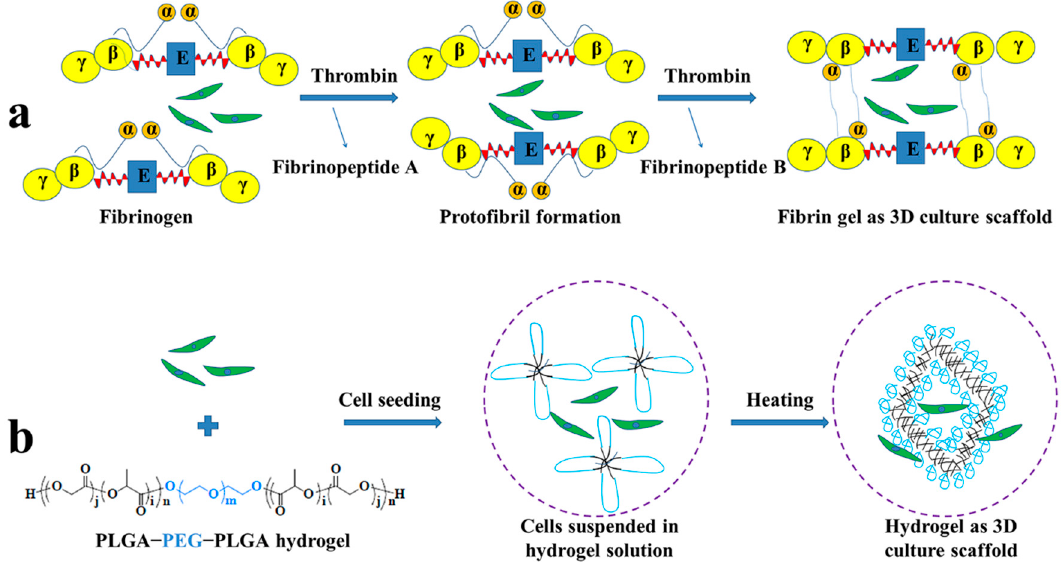
Figure 1. ( a ) Schematic representation of fibrin gel aggregation and BMMSCs incorporation; ( b ) BMMSCs-encapsulated PLGA − PEG − PLGA hydrogel acted as sca ff old for cartilage tissue engineering. Fibrinogen is composed of two sets of A α -, B β - and γ chains. Each α -chain is connected to the E-region through fibrinopeptide A and fibrinopeptide B. The D-region is linked with the E-region through a coiled segment. Thrombin-mediated cleavage of FPA induces the formation of a two-stranded protofibril. Subsequent cleavage of FPB releases α -chain from E-region and contributes to the lateral aggregation of two-stranded protofibrils and fibrin formation.